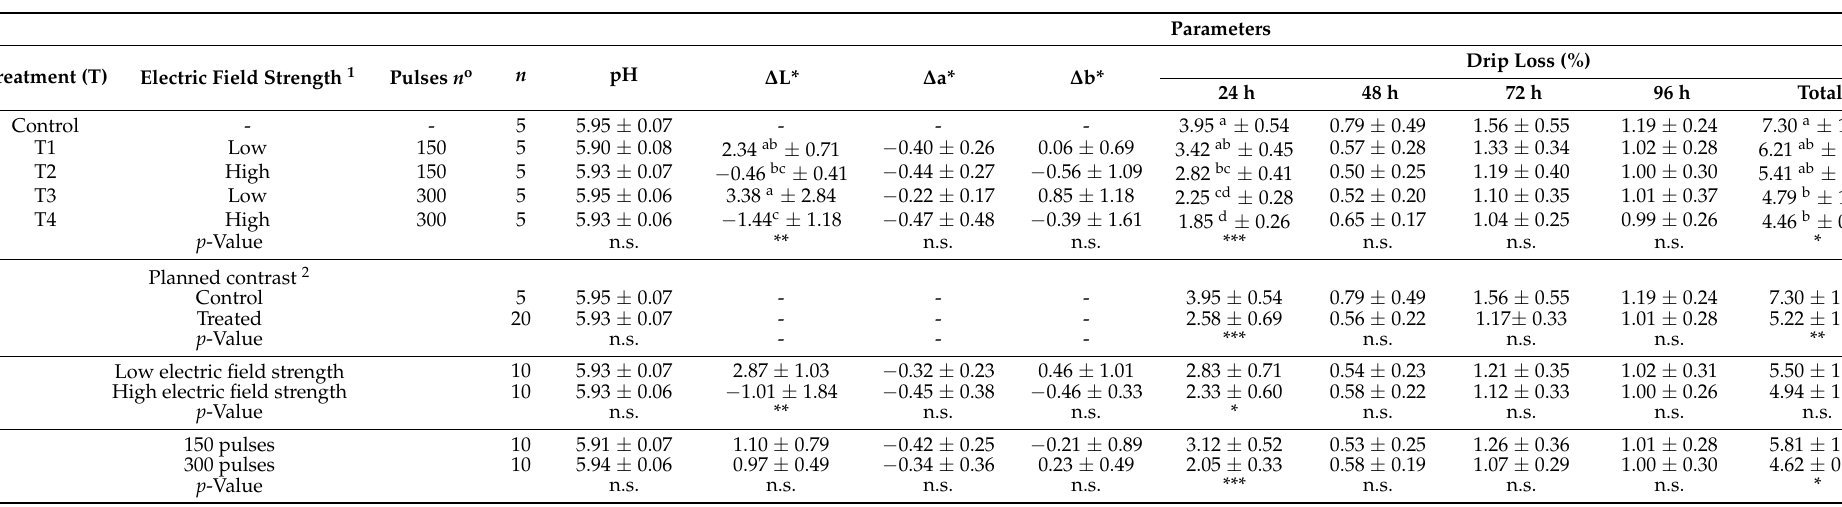
Table 3. Average pH, color variation ( ∆ L*, ∆ a*, ∆ b*), and water holding capacity (drip loss, %) of chicken meat samples subjected or not to pulsed electric field treatments. Data